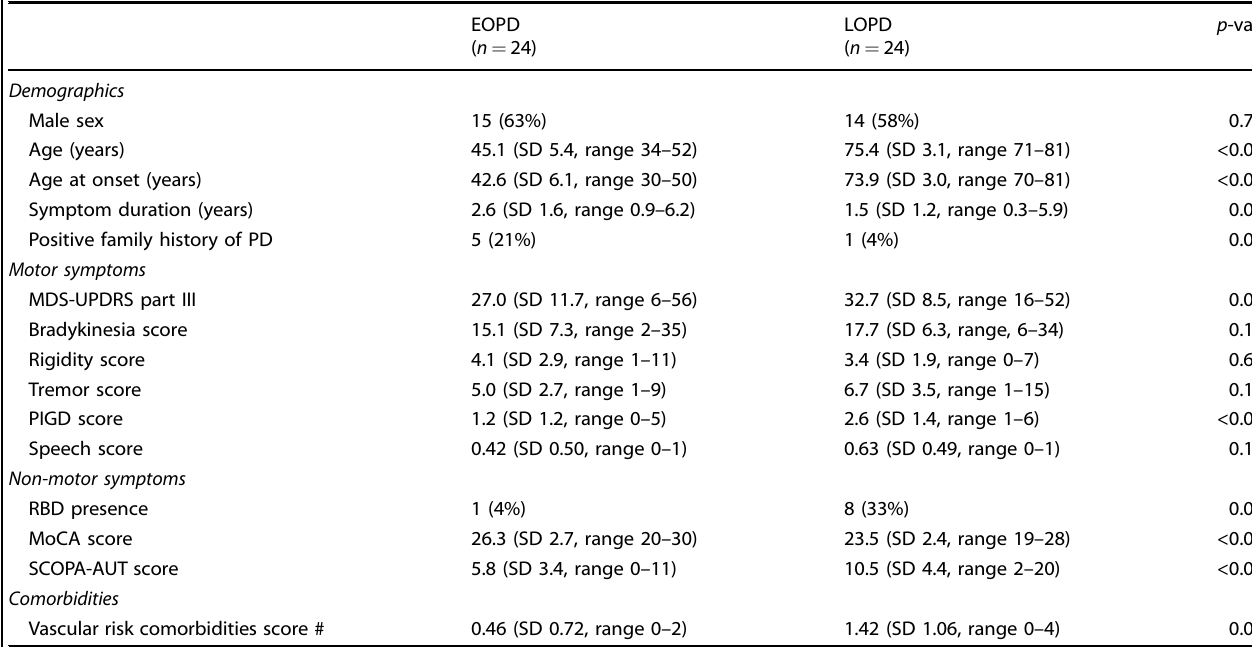
Table 1. Demographic and clinical characteristics for PD